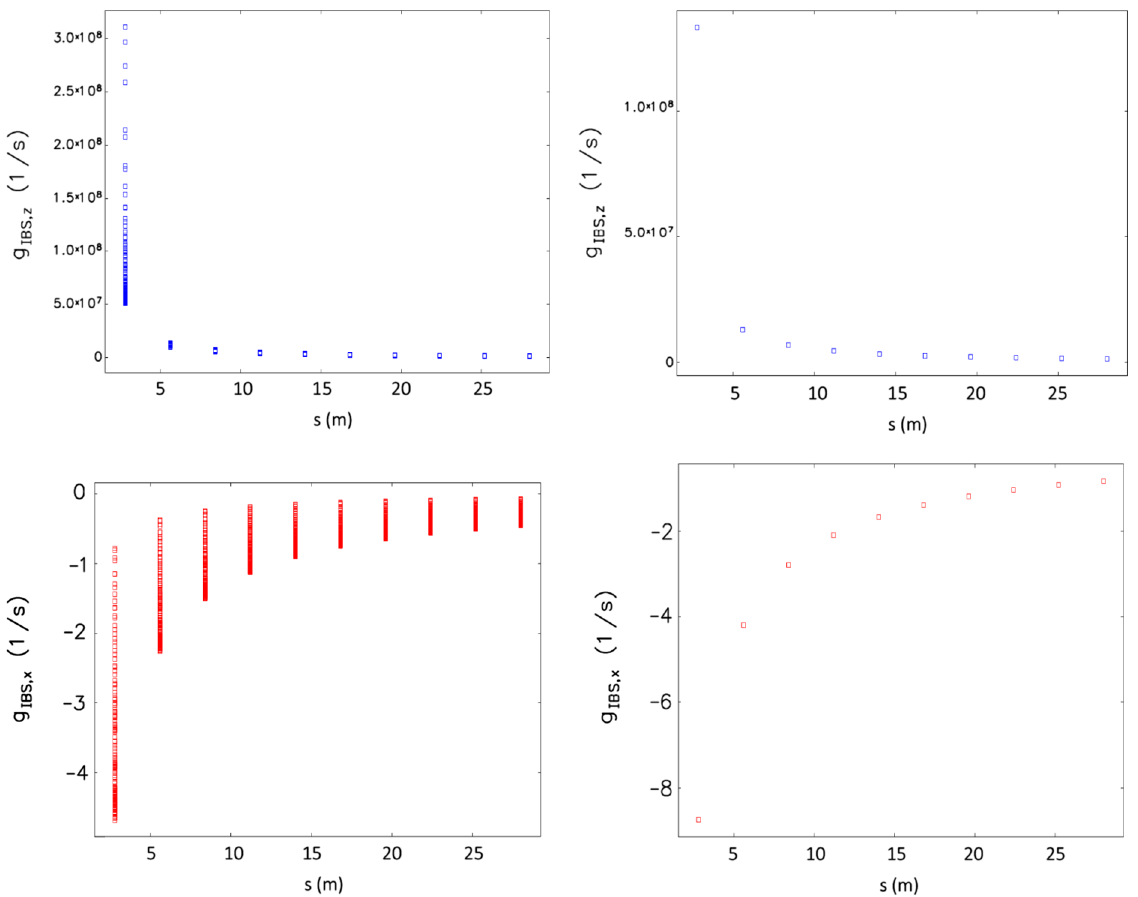
FIG. 4. IBS longitudinal (top) and transverse (bottom) growth rate for sliced (left) and unsliced bunch (right), along the FODO channel. Each point corresponds to one